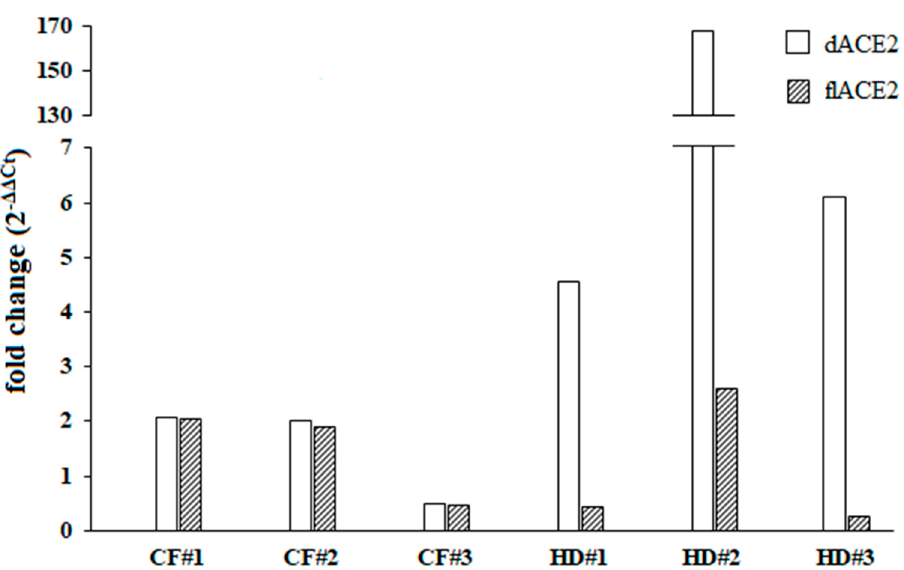
Figure 2. Fold change of the truncated angiotensin-converting enzyme 2 isoform (dACE2) and the full-length angiotensin-converting enzyme 2 isoform (flACE2) was shown individually for three different cystic fibrosis (CF) patients and healthy controls (HD) patients. Both dACE2 and flACE2 expression levels were examined before (T0) and after (T1) IFN β stimulation (5 ng/mL) for 24 h.